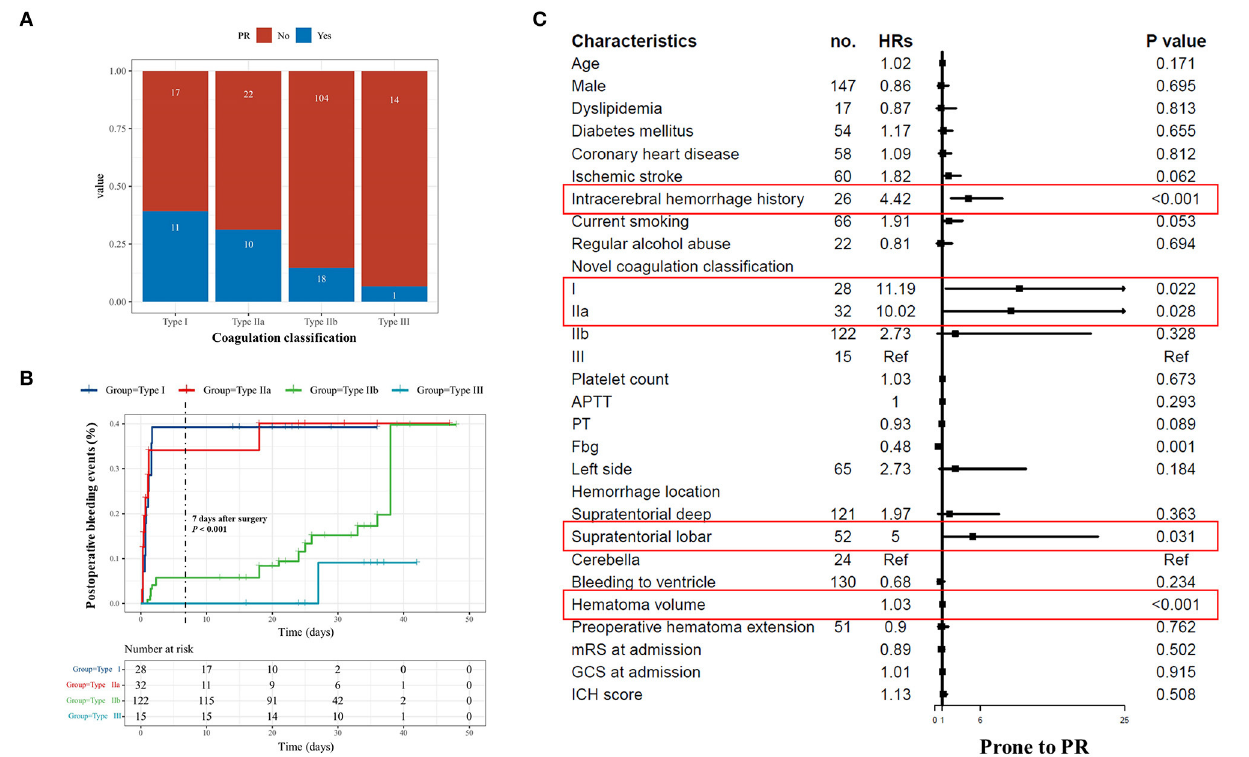
Frontiers in Aging Neuroscience |